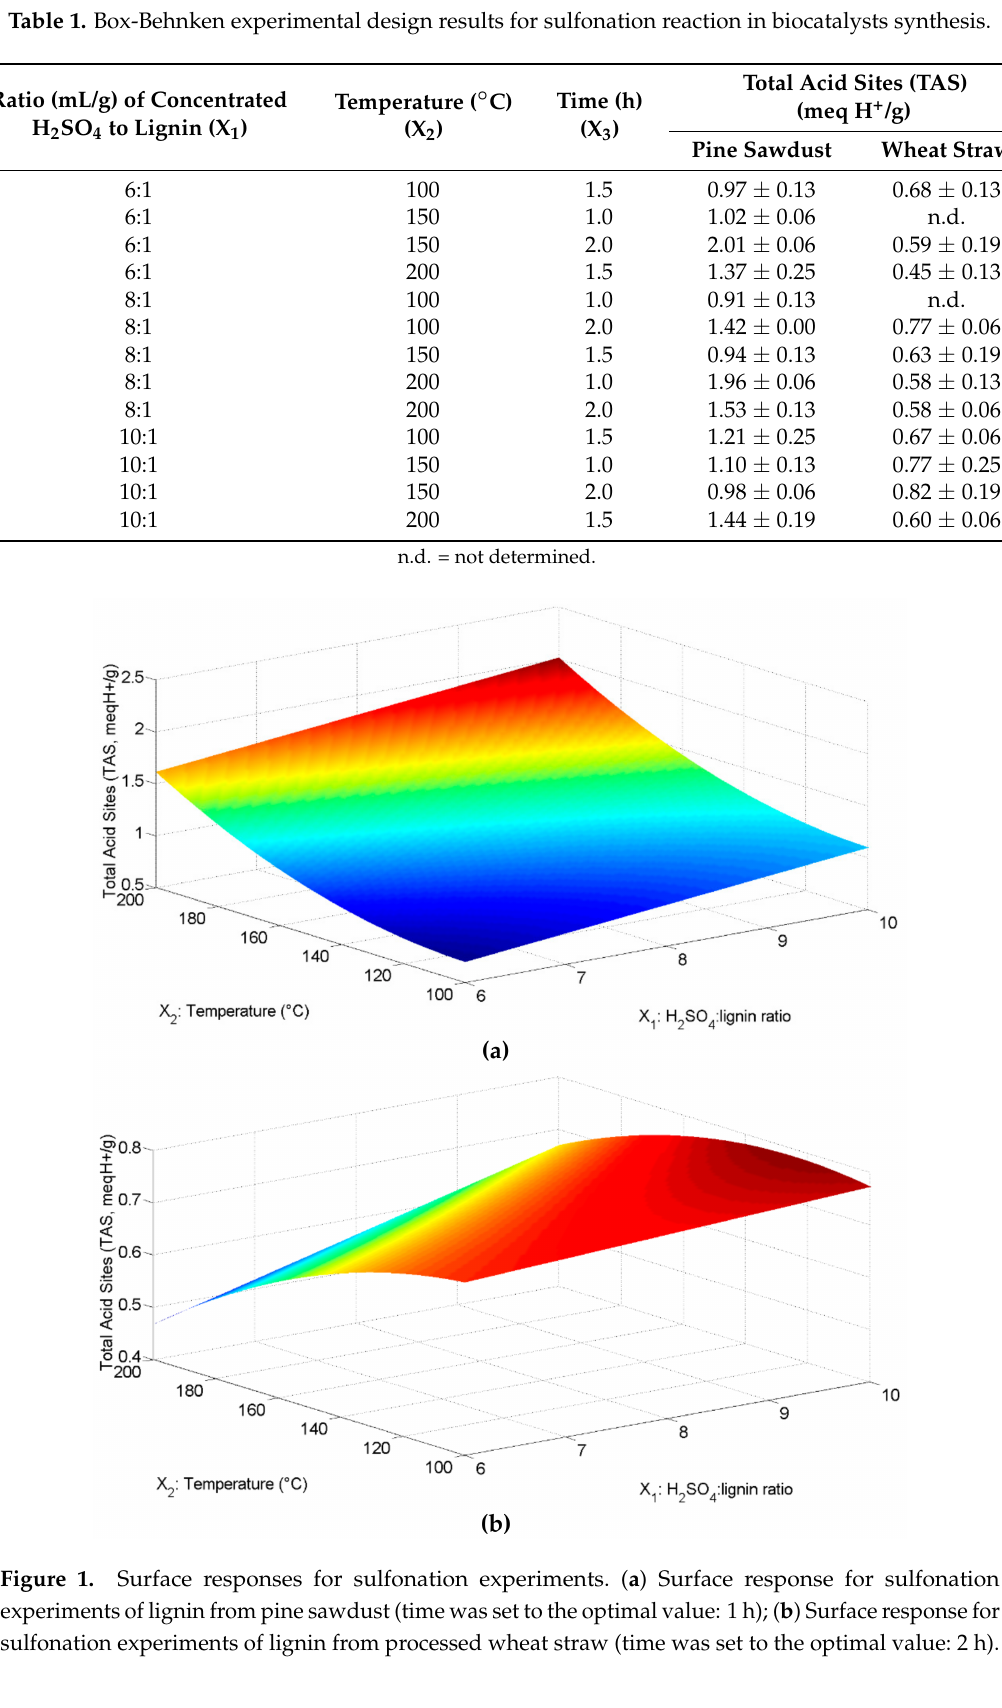
Table 1. Box-Behnken experimental design results for sulfonation reaction in biocatalysts synthesis.